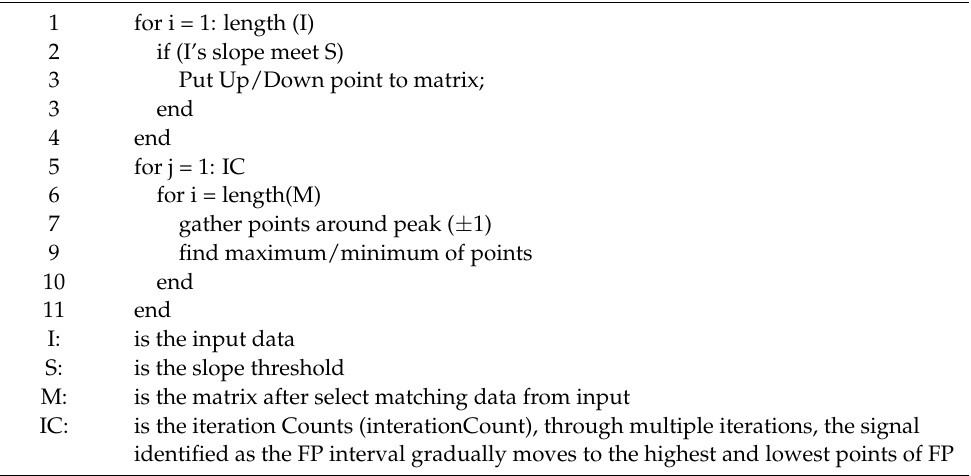
Algorithm 1. Proposed FP position